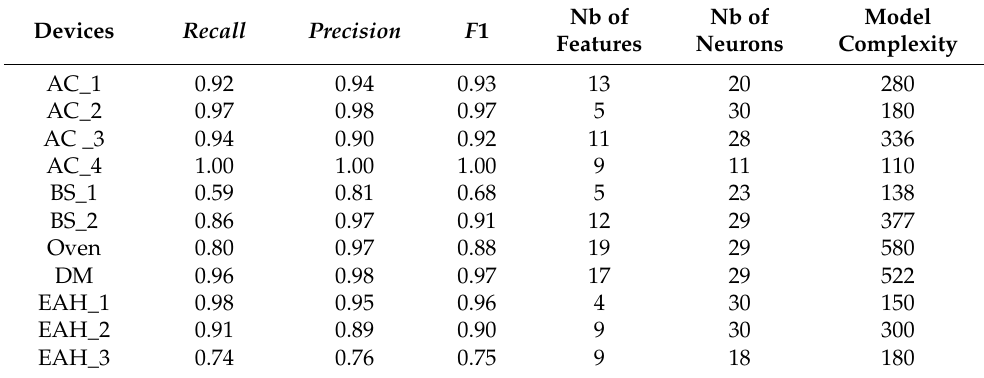
Table 23. Device state classification results.